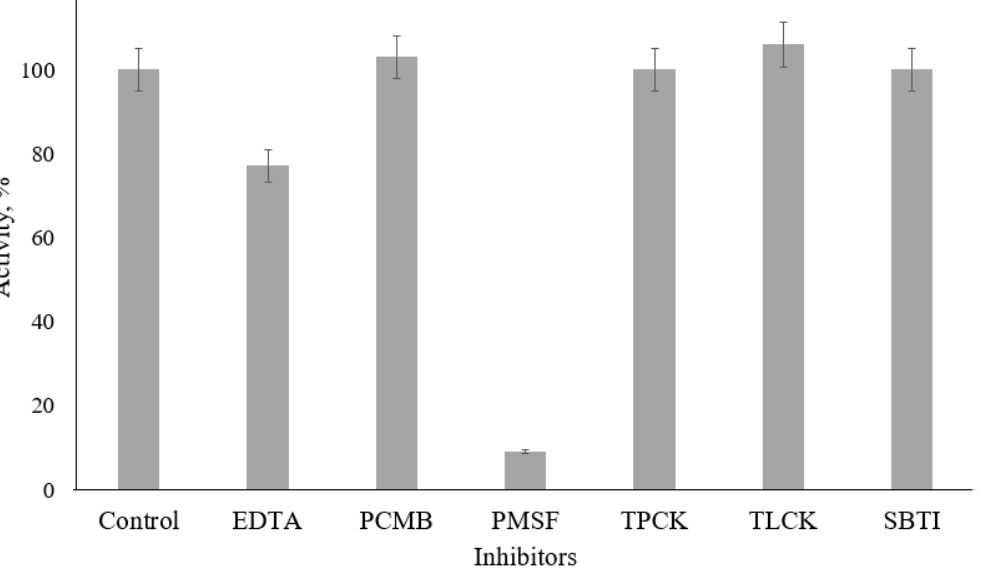
Figure 9. Effects of protease inhibitors on enzyme activity of the extracellular keratinase synthesized by Aspergillus clavatus VKPM F-1593.